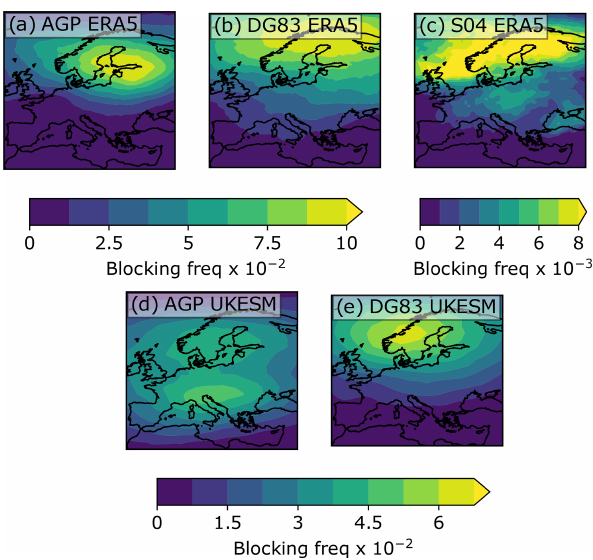
Figure A4. Occurrence of blocking events per grid cell across JJA Europe for three BIs in ERA5 1979–2019 and two BIs in UKESM JJA 1960–2060.